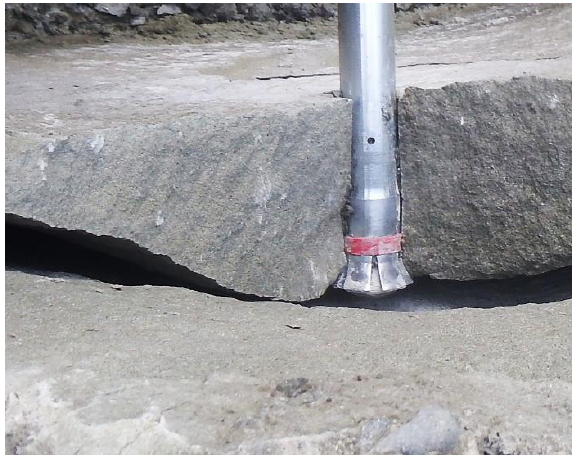
Figure 2. Rock fracture with a single undercut anchor.